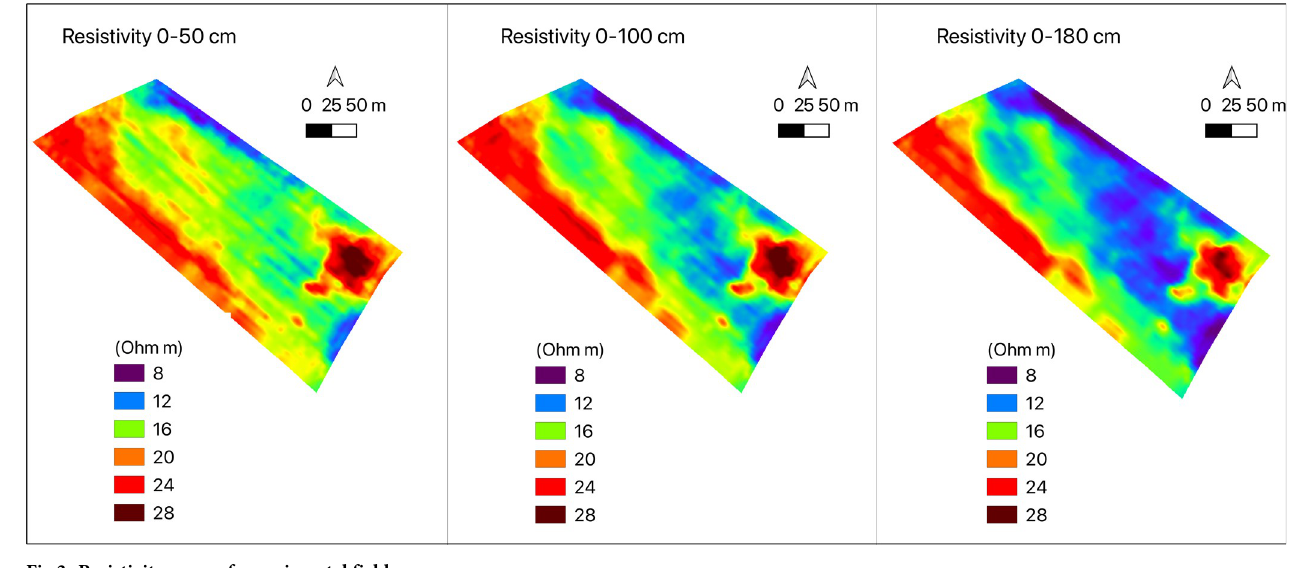
Fig 3. Resistivity maps of experimental field.